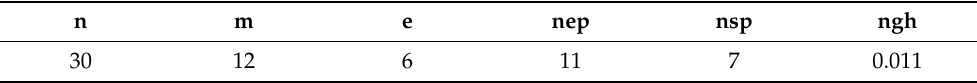
Table 2. The parameters of the proposed BA.